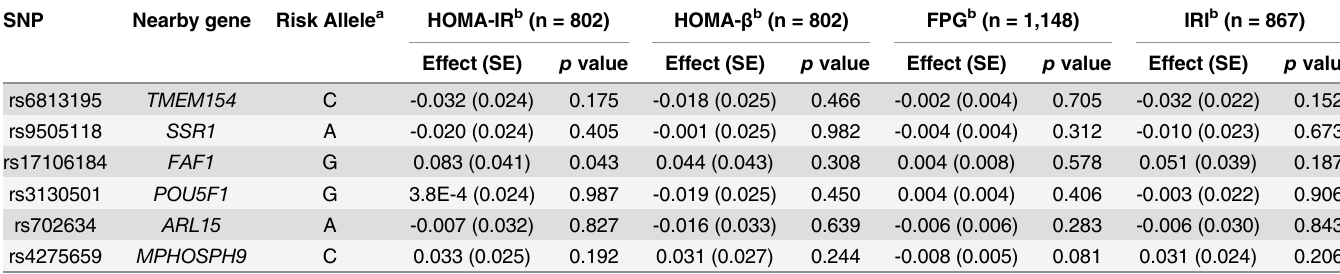
Table 3. Association of 6 SNP loci with quantitative traits related to glucose metabolism in control individuals.